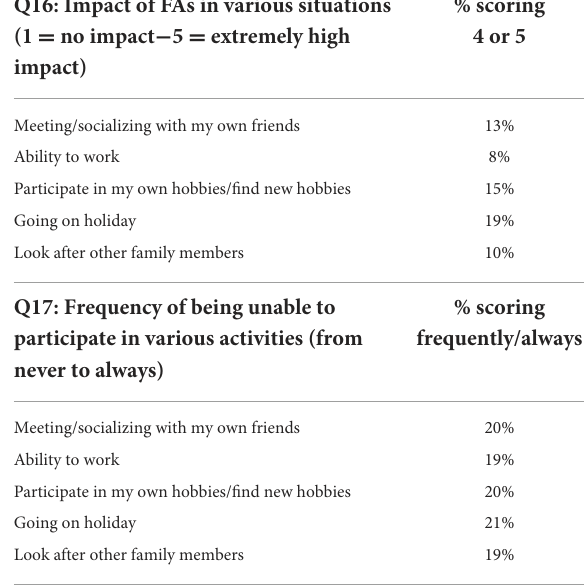
Q16: Impact of FAs in various